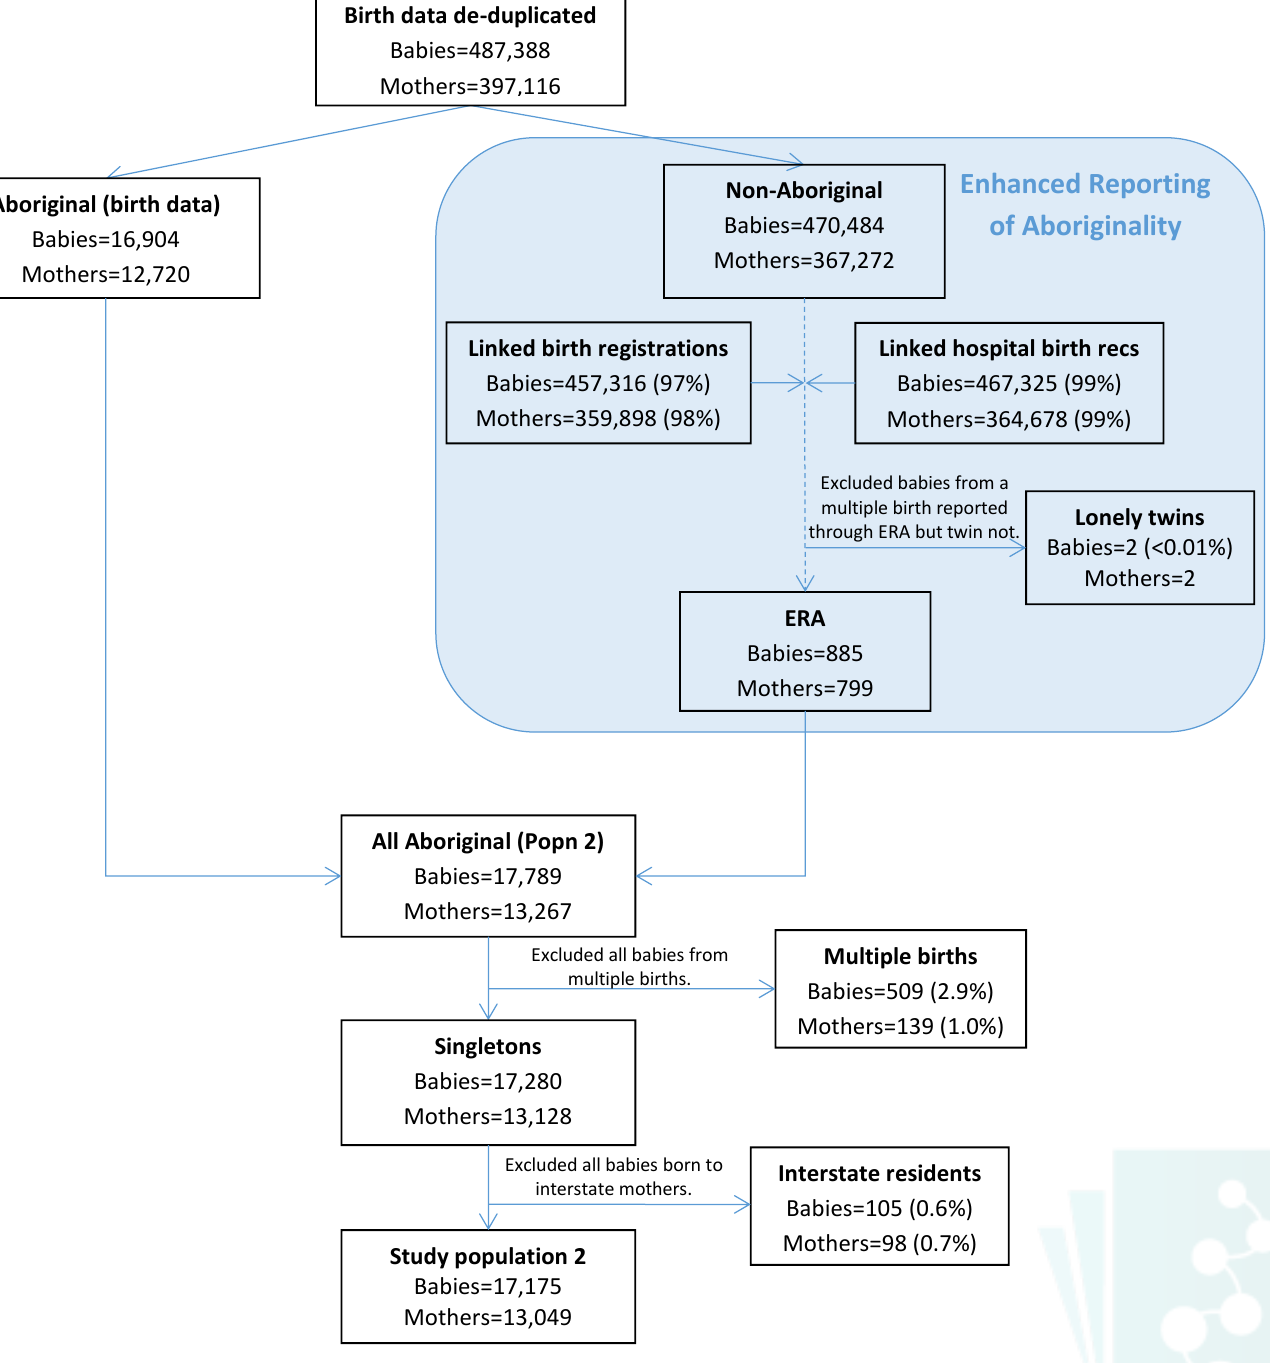
Figure 4: Flow diagram of mothers and babies eligible for enhanced inclusion in study population 2. Aboriginality of mothers in this study population was based on that recorded in the birth data and the enhanced reporting of Aboriginality from linked data records related to the